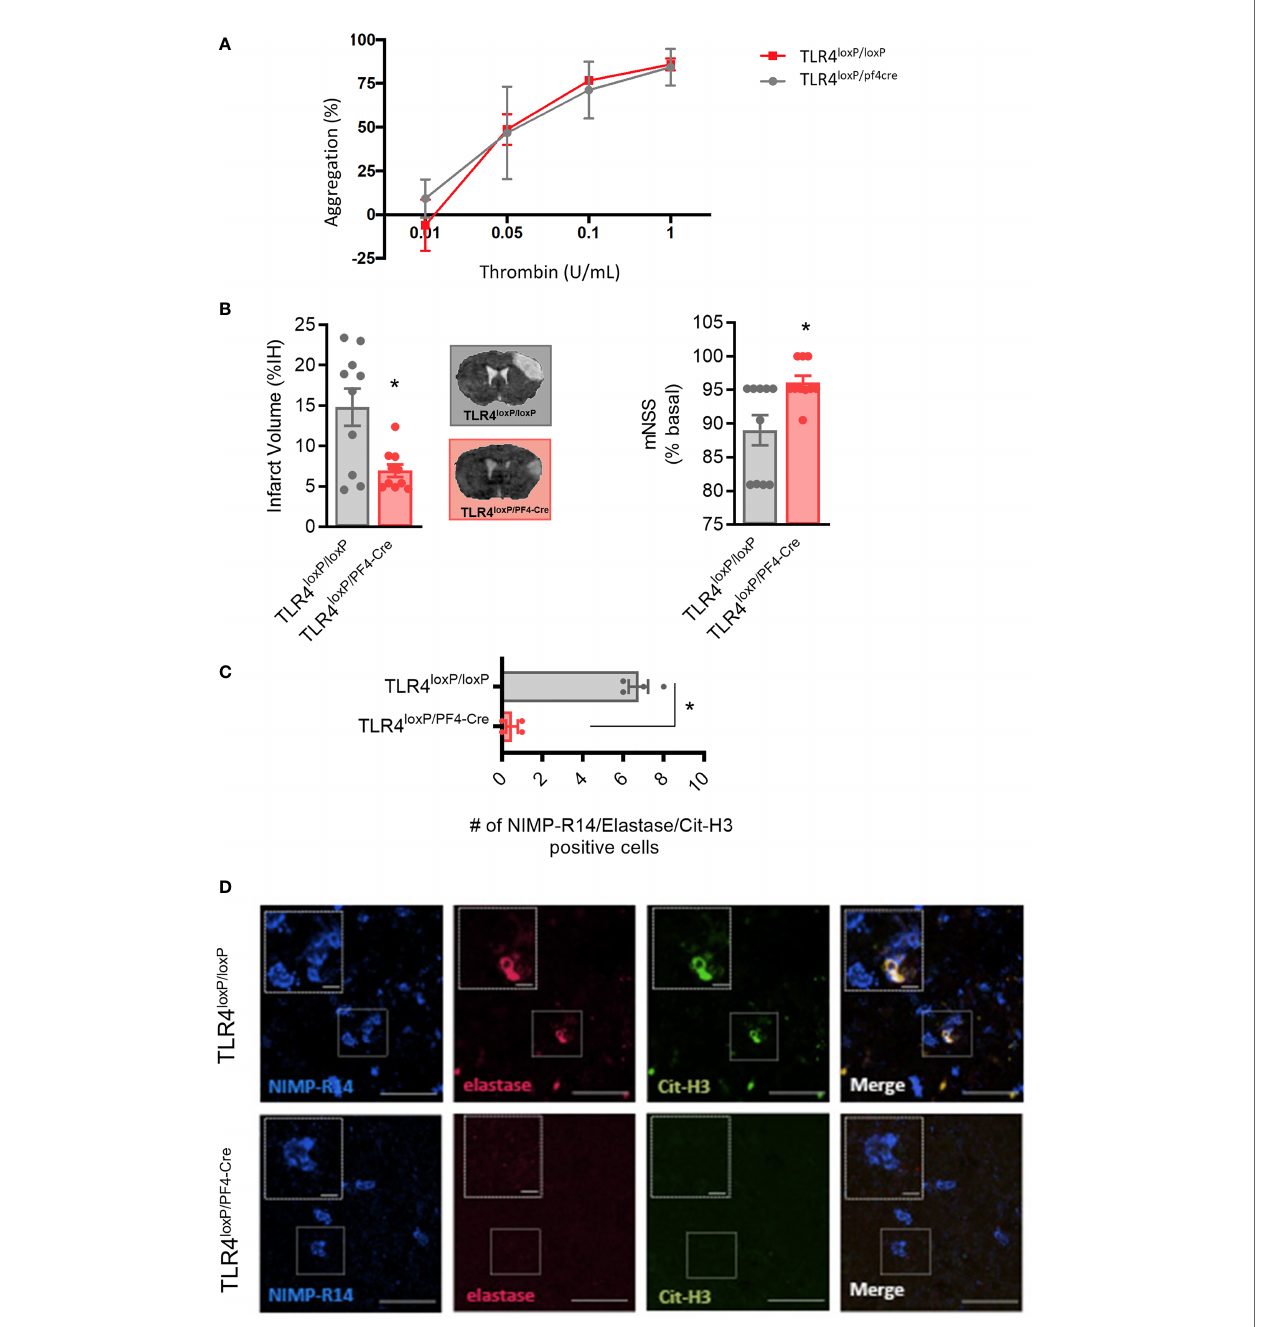
FIGURE 5 | Effect of deletion of TLR4 on platelets after stroke. (A) Effect of TLR4 deletion on platelet aggregation (B) Infarct volumes determined 24 hours after the occlusion. (C) Number of NIMP-R14, elastase and Cit-H3-positive cells. (D) Representative images. Data are mean ± SEM (n = 4-10 *p < 0.05 vs TLR4 loxP/loxP